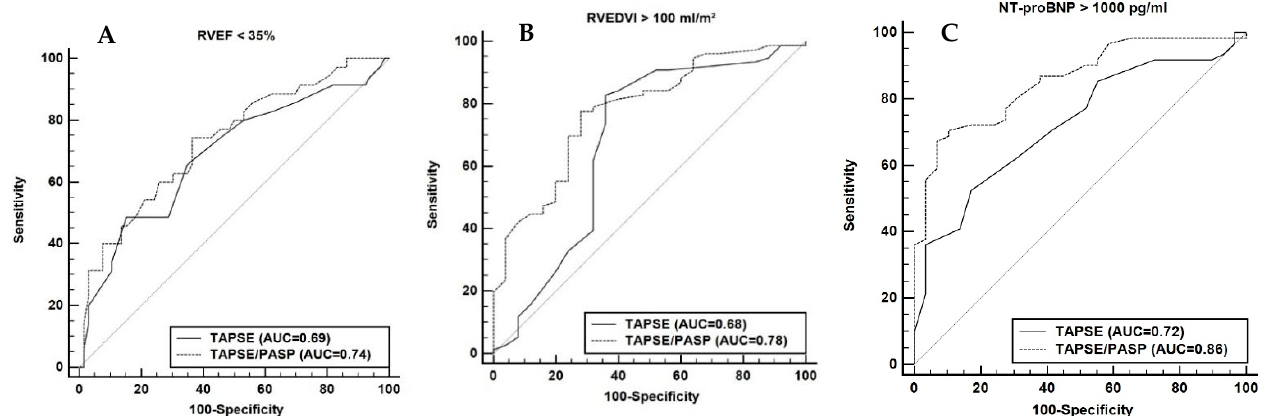
Figure 4. Receiver-operating characteristics curve showing the predictive power of TAPSE/PASP and TAPSE for ( A ) RVEF < 35%, ( B ) RVEDVI > 100 mL/m 2 and ( C ) NTpro-BNP > 1000 pg/mL.